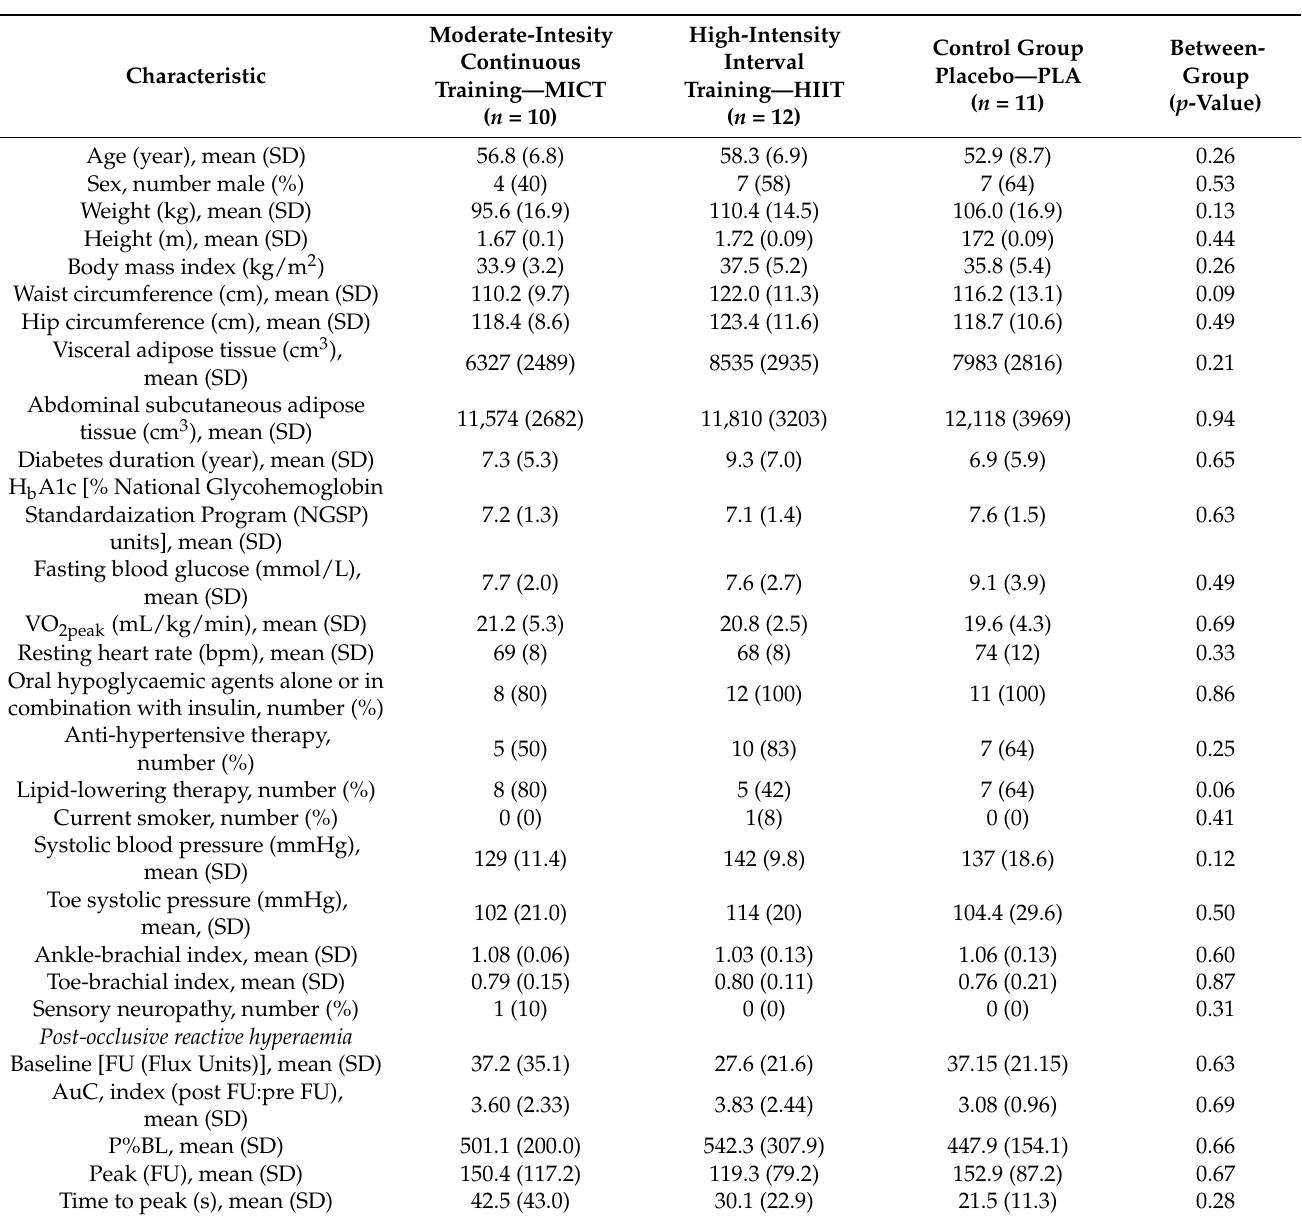
Table 1. Characteristics of participants at baseline.